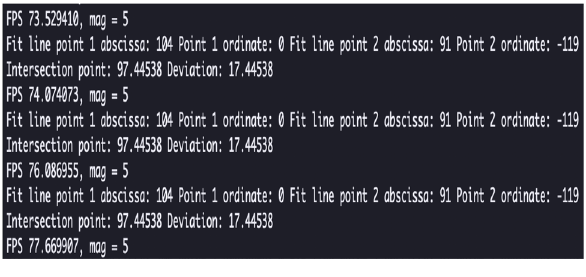
Fig. 13 Program terminal result